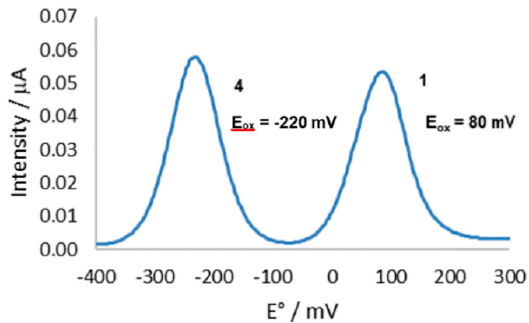
Figure 1. Differential pulse voltammogram obtained for probe 1 (0.5 mM) and aminoferrocene 4 (0.5 mM) in MeCN:Tris buffer (pH 9, 50 mM).